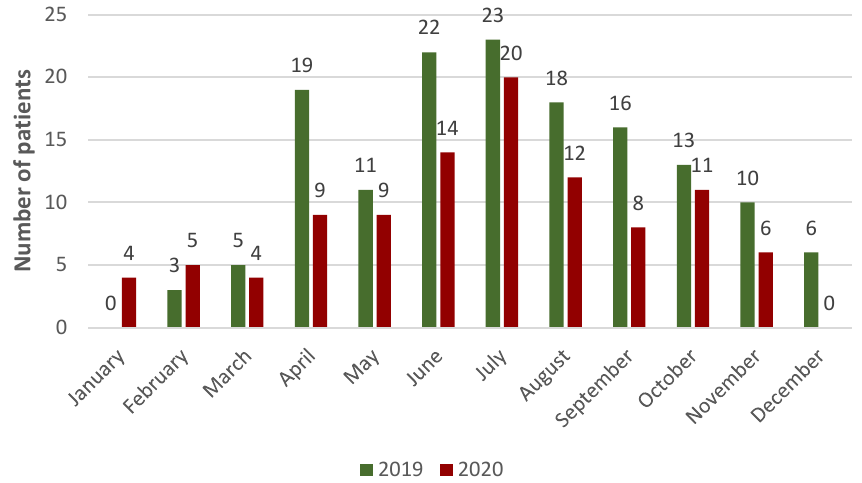
Figure 1. Number of incidents, including months in the audited period of 2019–2020.